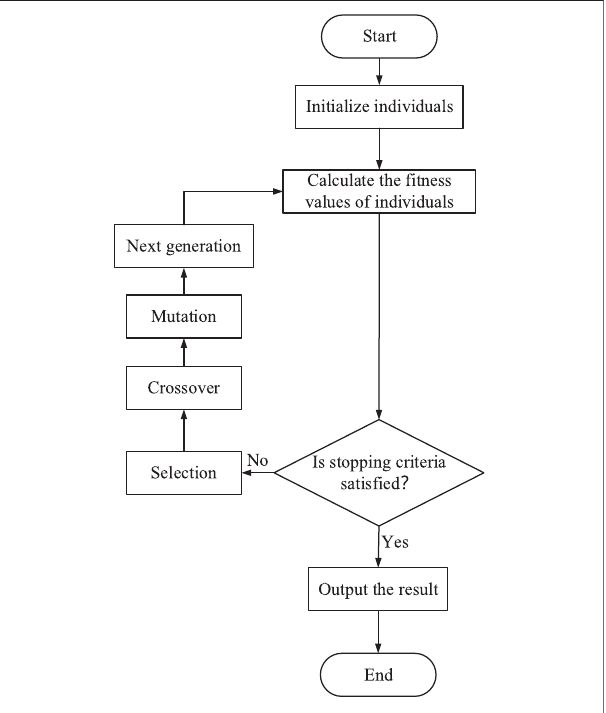
FIGURE 6 | Calculation procedure of